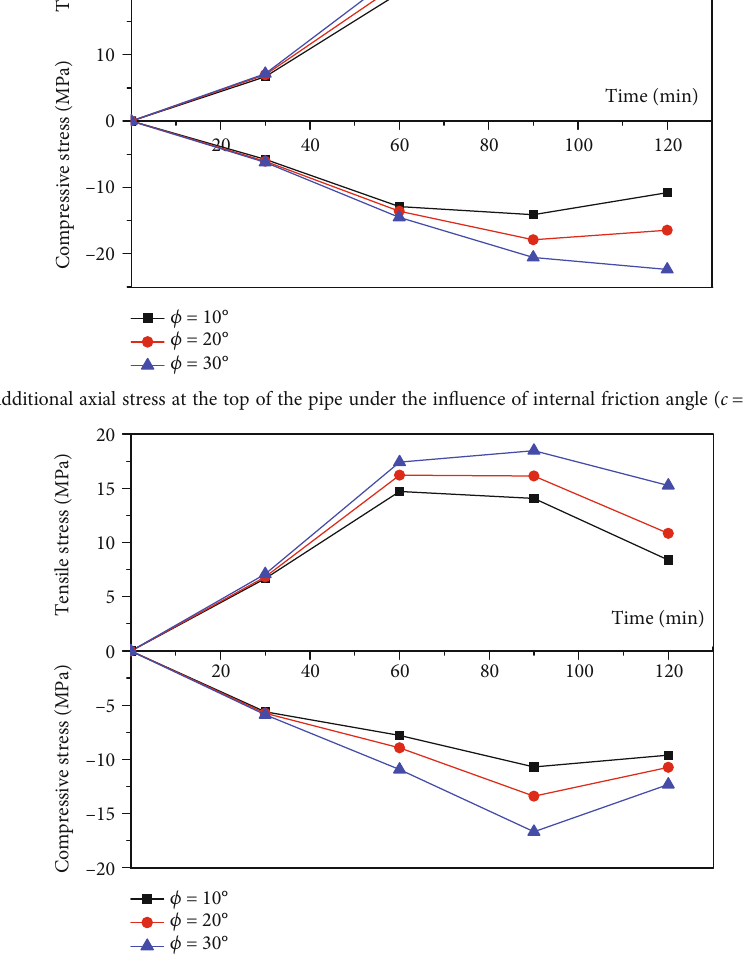
(b) Additional axial stress at the top of the pipe under the in fl uence of internal friction angle ( c = 0kPa ) Figure 16: In fl uence of soil parameters on additional axial stress in